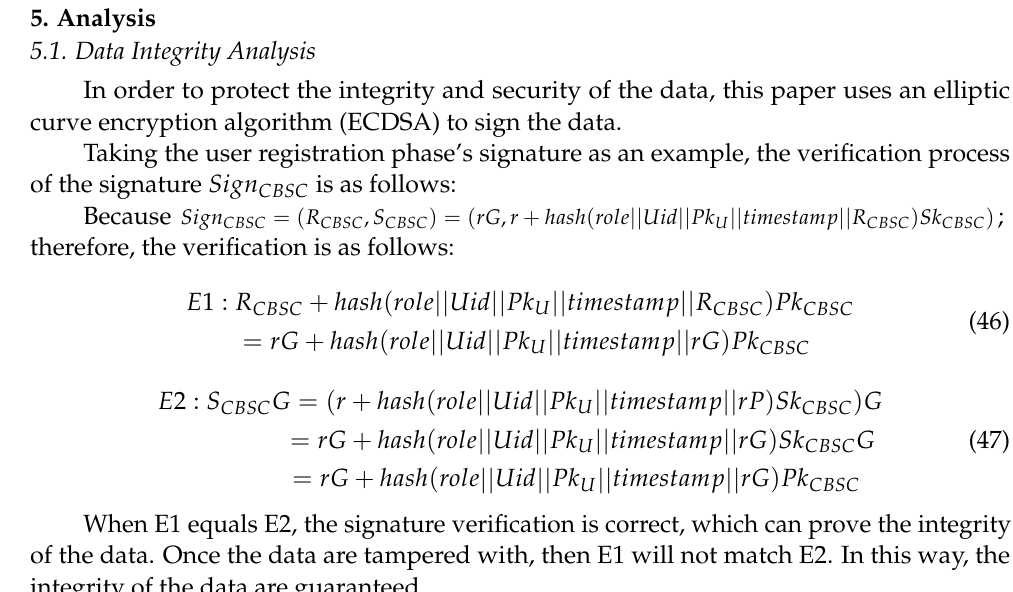
Figure 10. The flow chart of s canning of access voucher and acquisition of re-encrypted EMR.